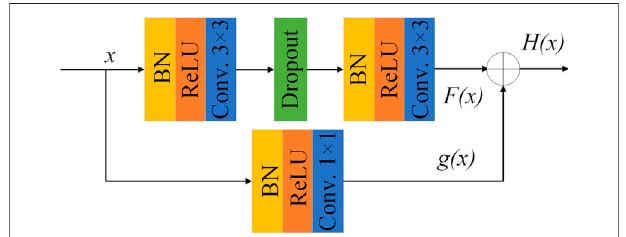
FIGURE 1 | Schematic diagram of residual